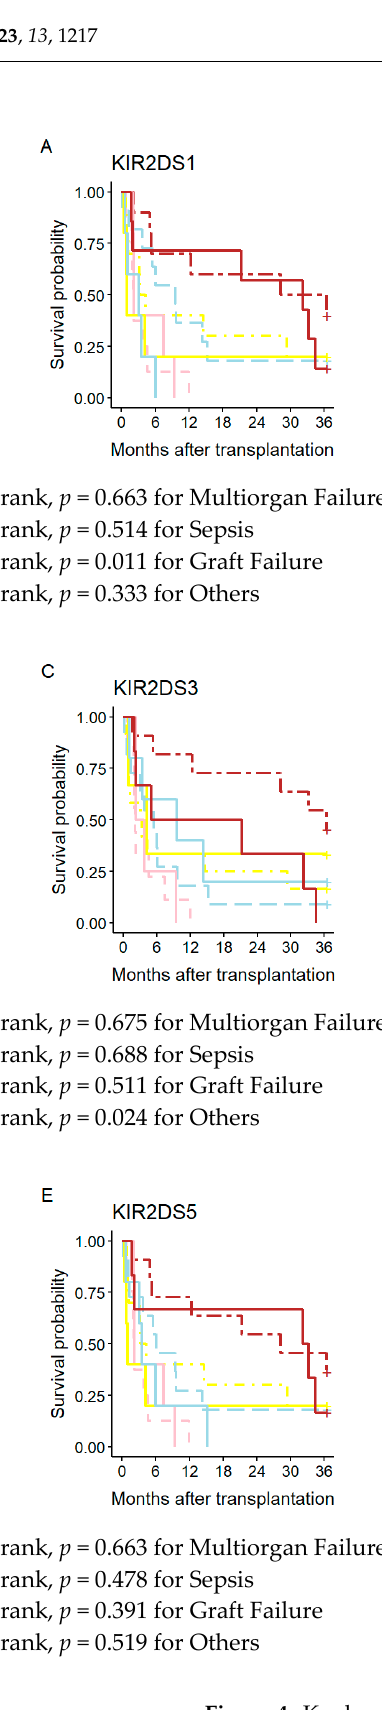
Figure 4. Kaplan–Meier patient survival curves based on the main cause of death and KIR genes. ( A ) Kaplan–Meier patient survival curves according to the presence of KIR2DL3+. ( B – F ) Kaplan– Meier patient survival curves according to the presence of KIR2DS2+ , KIR2DS3+ , KIR2DS4+ and KIR2DS5+ , KIR3DS1+